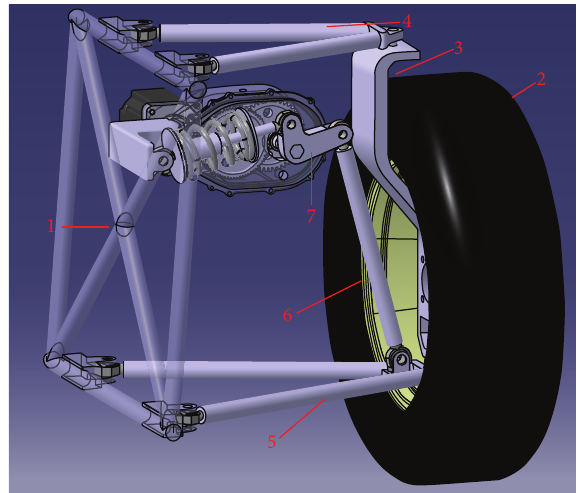
Figure 2: Gearbox type active suspension structure. (1) Frame; (2) wheel; (3) knuckle; (4) upper A-arm; (5) lower A-arm; (6) push bar; (7) actuator.